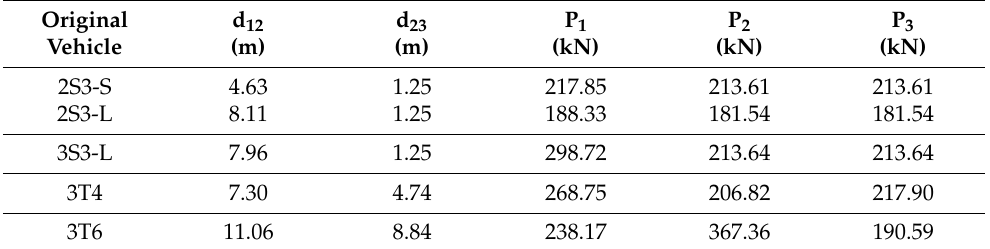
Table 6. GVWs and wheelbases of standardized 3C equivalent vehicles for each truck class.